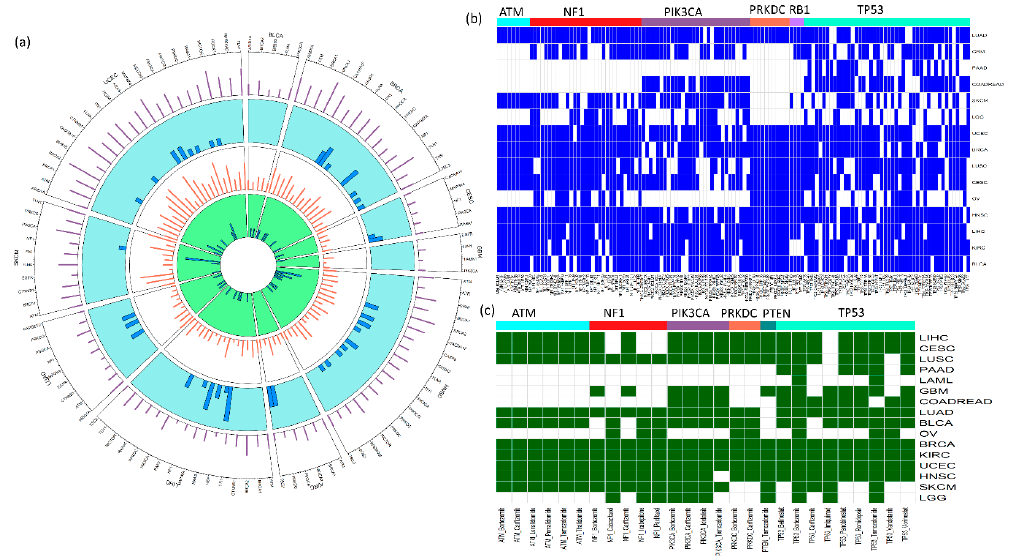
Figure 2. Summarization of cancer-specific synthetic lethality data presented in SL-BioDP: ( a ) Circos plots displaying the summary of synthetic lethal interactions of 63 cancer genes that are common in at least five cancer types. The outermost layer (layer 1) shows the number of predicted synthetic lethals per gene. The next layer (layer 2) shows histograms of the number of mutations per gene. The next to last layer (layer 3) shows the number of drugs identified per gene, through their synthetic lethal partners. Finally, the innermost layer (layer 4) displays histograms of the number of enriched synthetic lethal pathways per gene; ( b ) the table shows all common synthetic lethal pairs with high